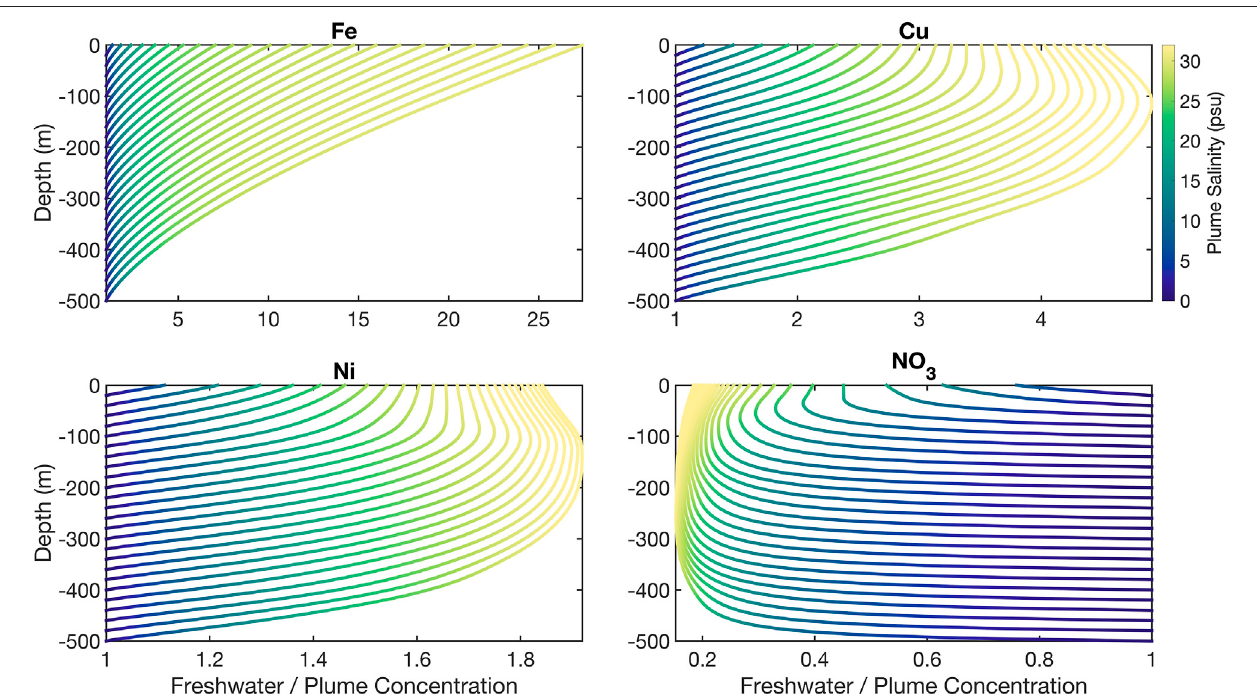
FIGURE 8 | Ratio of dissolved Fe, Cu, Ni, and NO 3 derived from freshwater in modeled glacier plumes using pro fi les from the Greenland shelf. Depth indicates the grounding lineofaglacierfrom which 500 m 3 s − 1 freshwater discharge isreleased.Each coloured linerepresentsthesamedischarge released at varying grounding line depths. When the x axis values approach 1 or less at 0 m, surface lateral trends are driven mainly by the properties of in fl owing saline waters rather than by freshwater properties. The relative signi fi cance of freshwater concentration to determining nutrient concentrations in the resulting plume (x axis) can be seen to decline in the order dFe > dCu > dNi > NO 3